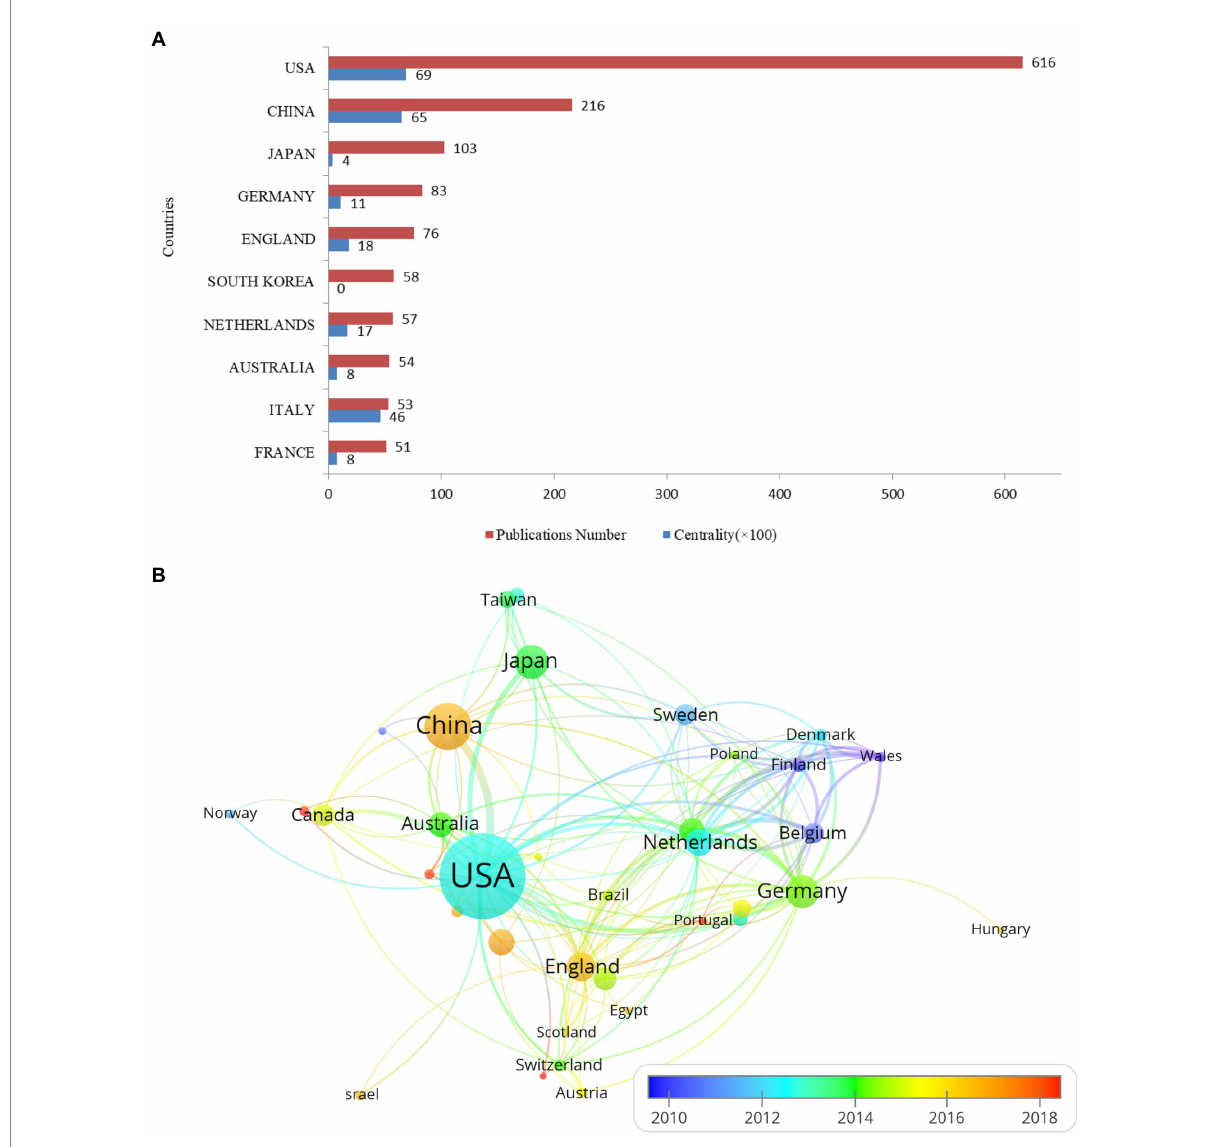
FIGURE 4 Top 10 productive countries on aged-related hearing loss research from 2002 to 2021 (A) and (B) cooperation network map of countries/regions. United States, United State of